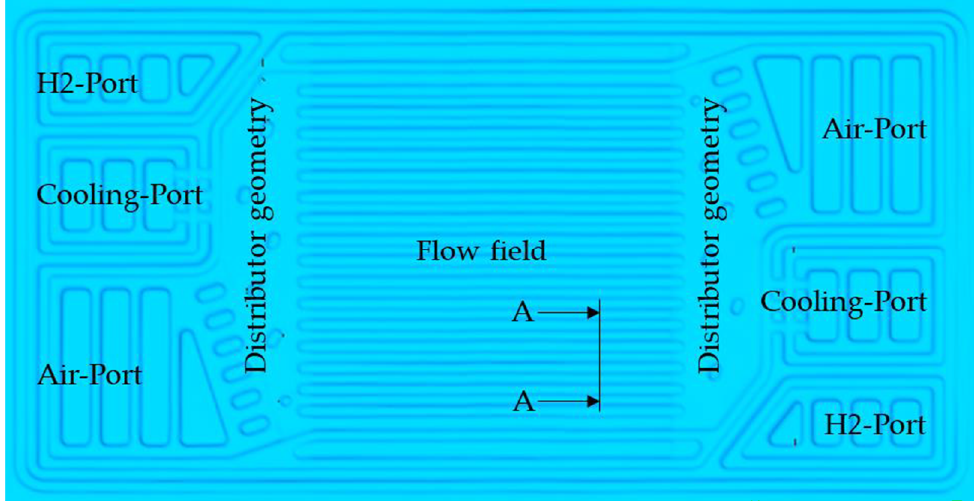
Figure 5. Accuracy of mapping of the bipolar plate geometry.